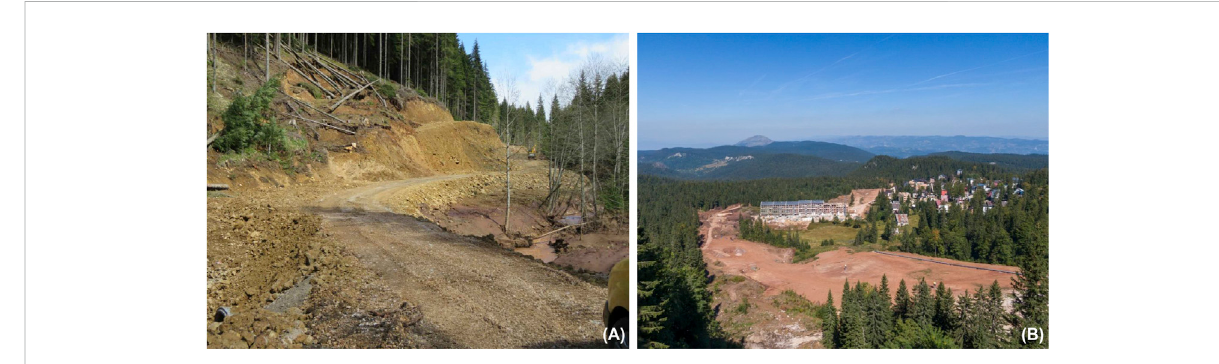
FIGURE 3 Forest devastation caused by construction on Jahorina [sources: (A) Ekapija, 2021; (B) Filter,